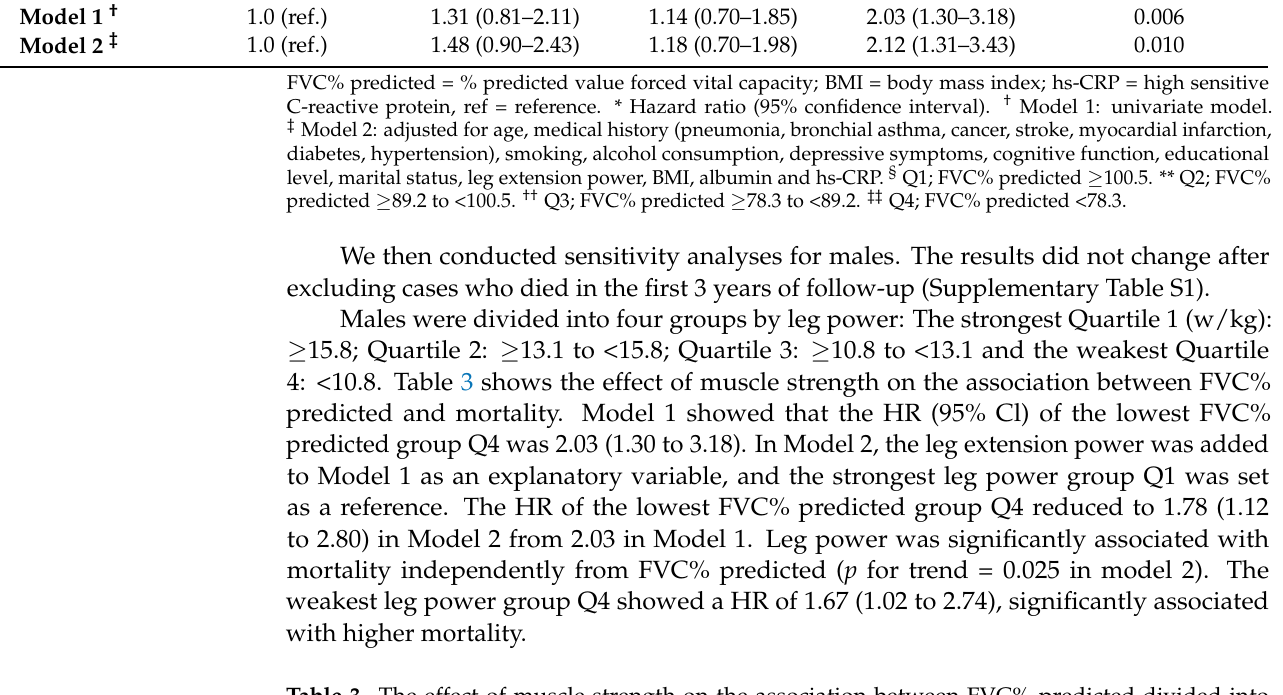
Table 3. The effect of muscle strength on the association between FVC% predicted divided into quartiles and mortality